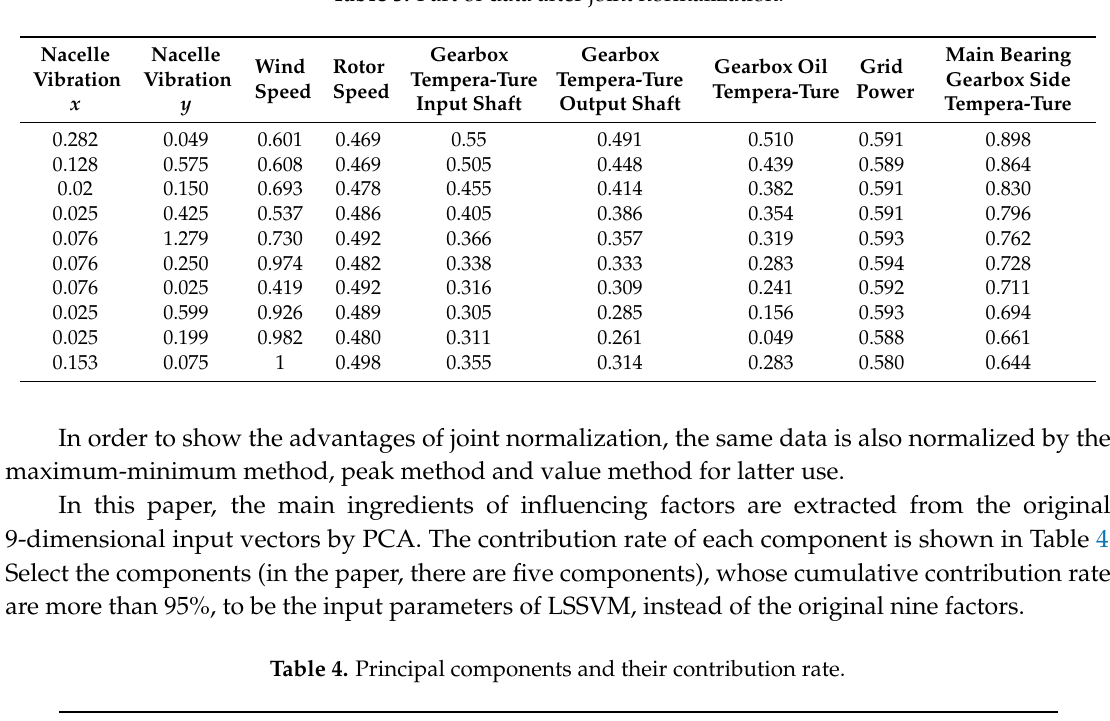
Table 3. Part of data after joint normalization.